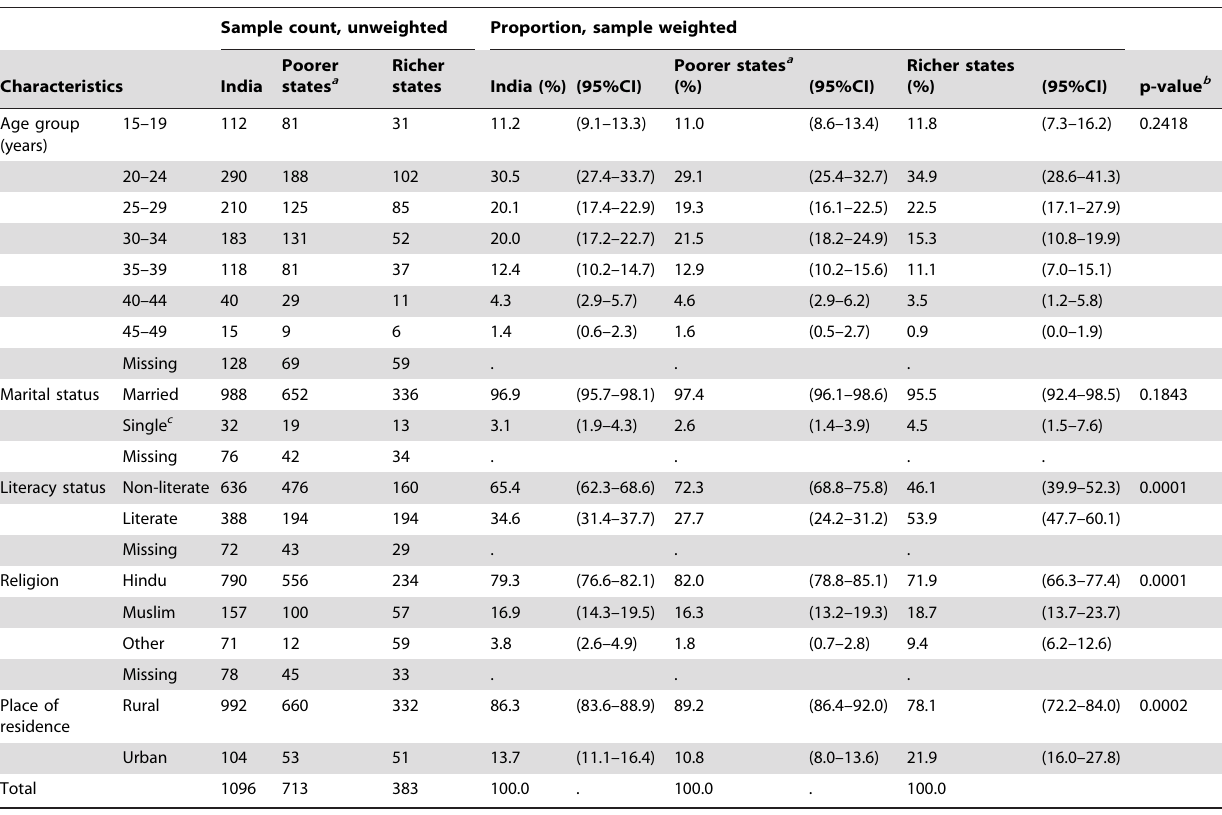
Table 1. Sample characteristics of 1096 maternal deaths.